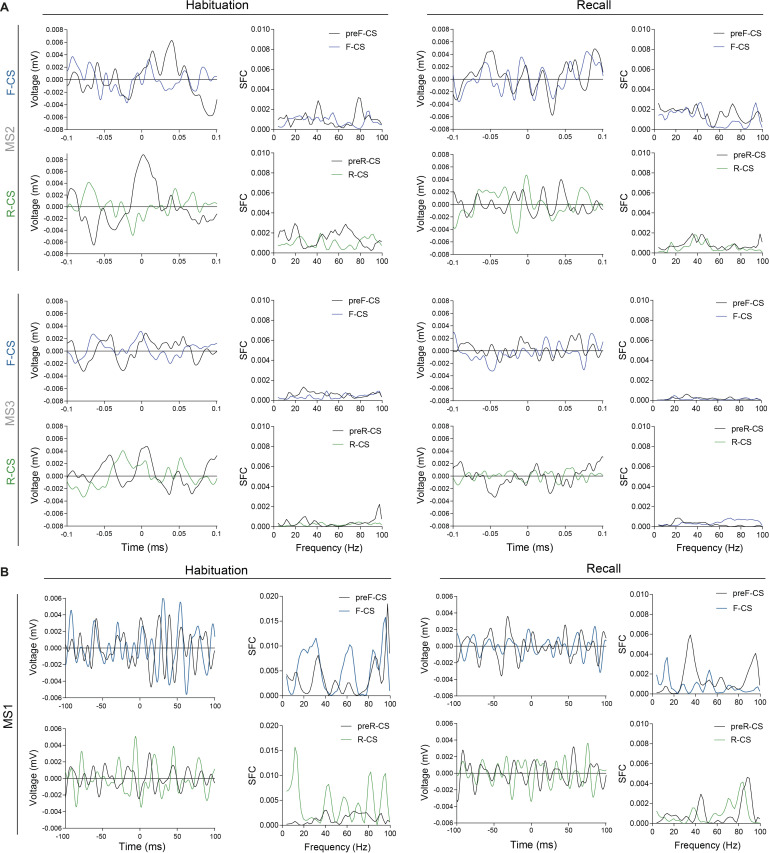
The aIC–pIC hierarchy is direction-asymmetric and performance-dependent.(A) Valence-resolved STA of 200 ms pIC LFP traces centered around the occurrence of spikes from aIC and the resulting pIC LFP power-normalized SFC thereof for habituation and recall for worse-performing animals (MS2 and MS3 in Figure 1—figure supplement 8A). (B) Valence-resolved STA of 200 ms aIC LFP periods centered around the occurrence of spikes from pIC and the resulting aIC LFP power-normalized SFC thereof for habituation and recall for animal MS1 (as in Figure 3B).